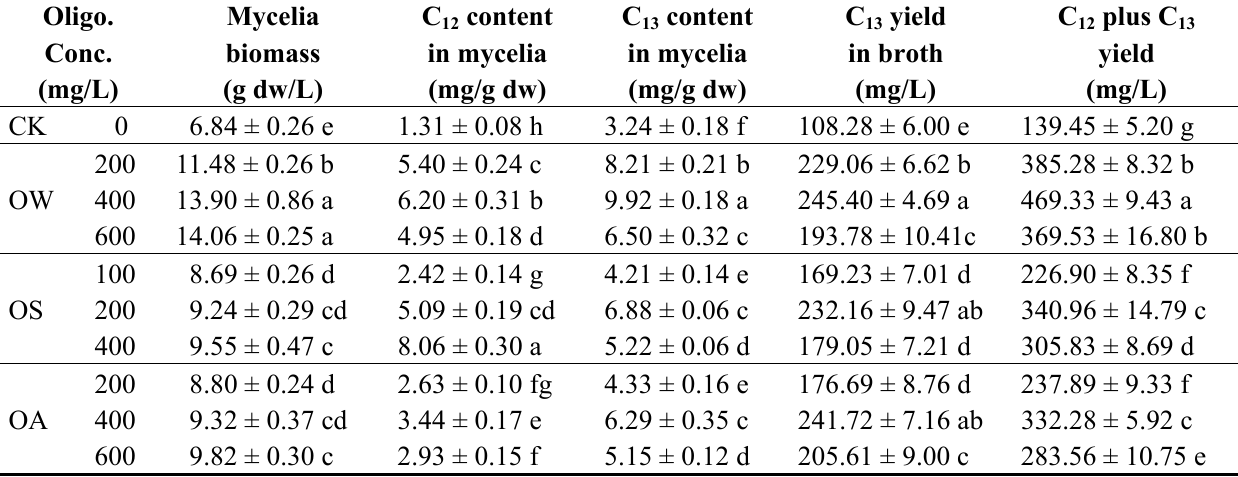
Table 1. Effects of the oligosaccharides OW, OS and OA on mycelia growth